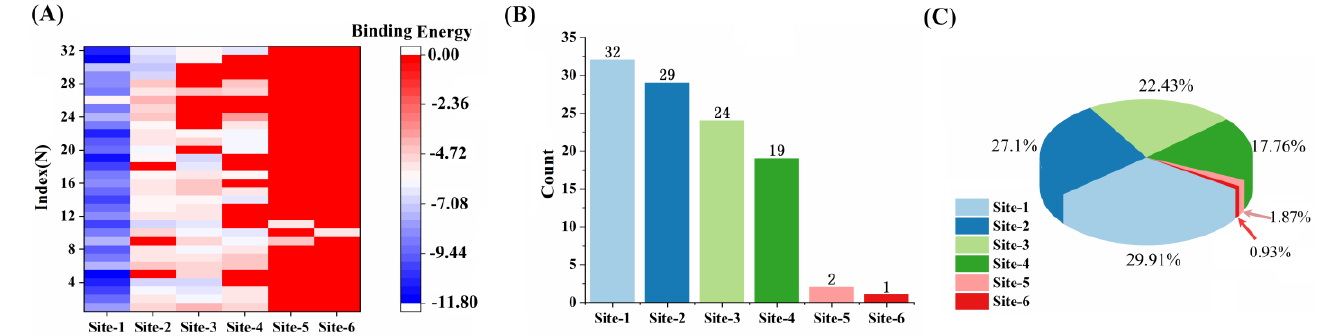
Figure 3. ( A ) Binding energy for probes 1–32 on different binding sites in A β . ( B ) The count numbers among all possible binding sites for the probes in A β . ( C ) The proportion of multiple binding sites among all possible binding sites.